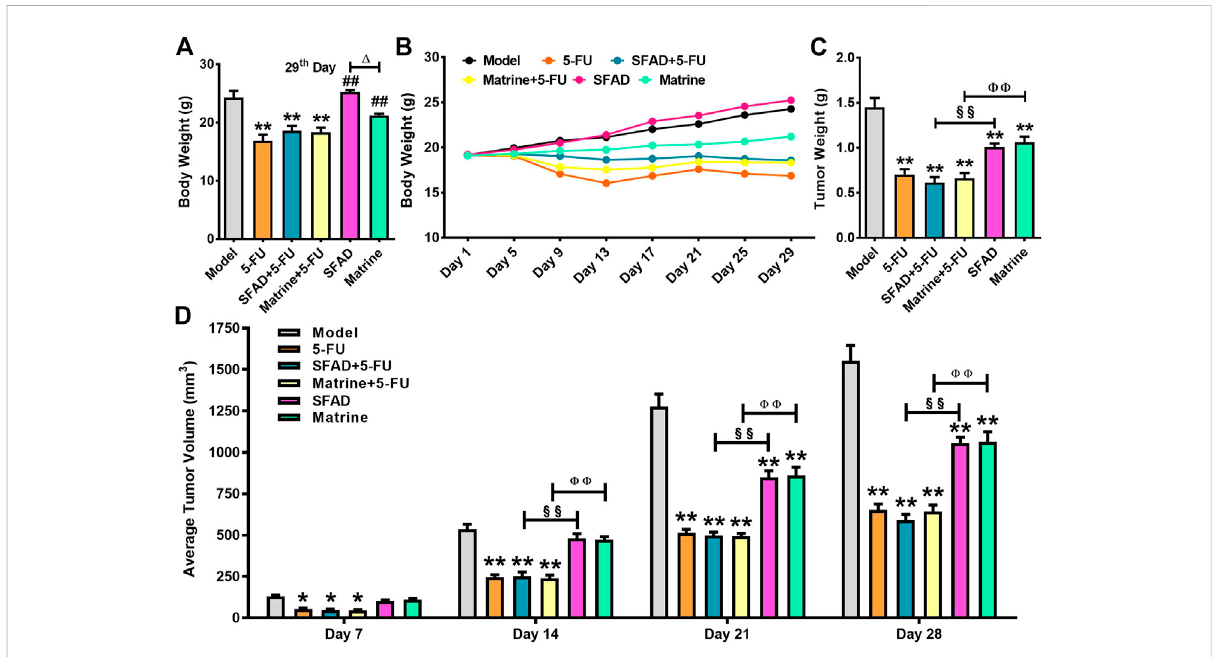
FIGURE 2 EffectsofSFA/matrine+5-FUonBW,averagetumorweight,andtumorvolumeofBGC-823-transplantednudemice. (A) AverageBW(g)onday 29. (B) ChangesinBW(g)overthe29-daytrialperiod. (C) Averagetumorweight(g)onday29. (D) Averagetumorvolume(mm 3 )ondays7,14,21,and 28.Dataarepresentedasthemean±SDofeightnudemice.* p < 0.05,** p < 0.01vs . themodelgroup; ## p < 0.01vs . the5-FUgroup; △ p <